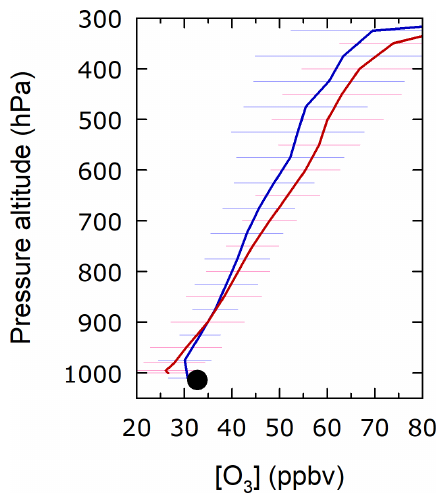
Figure 11. Average profile from O 3 soundings (blue) and that from TCR-2 (red). Average from surface observations on R/V Mirai is shown as black circle.